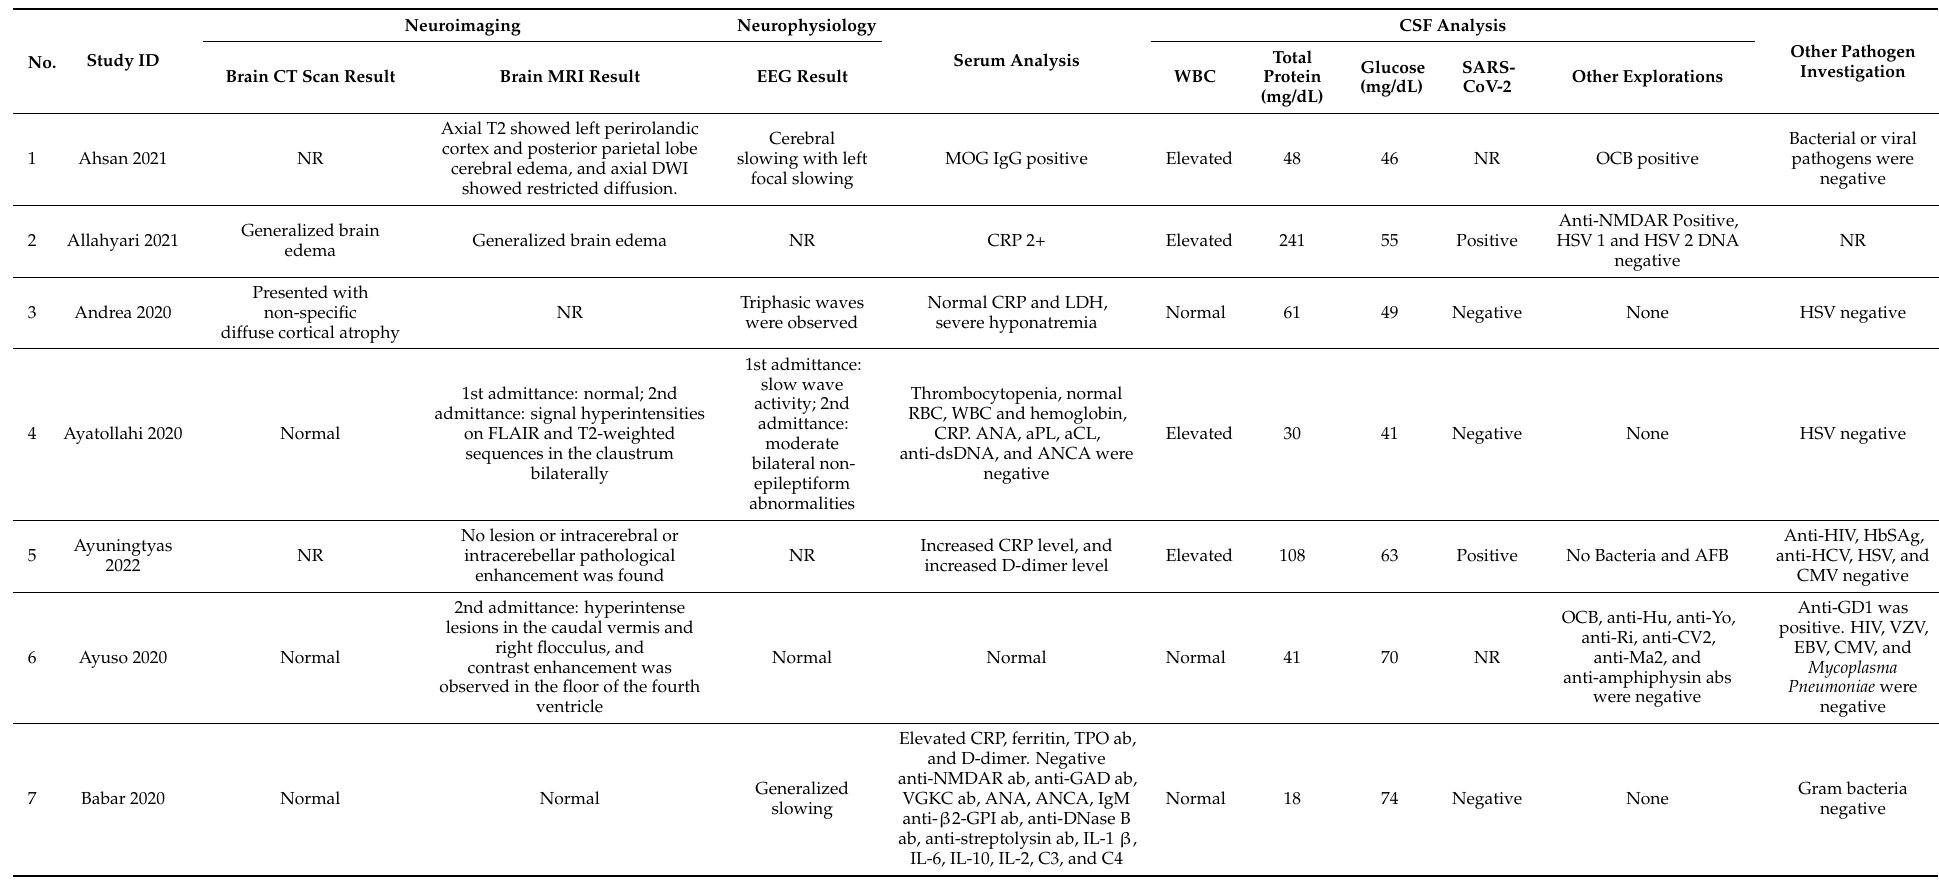
Table 2. Diagnostic features of encephalitis in patients with